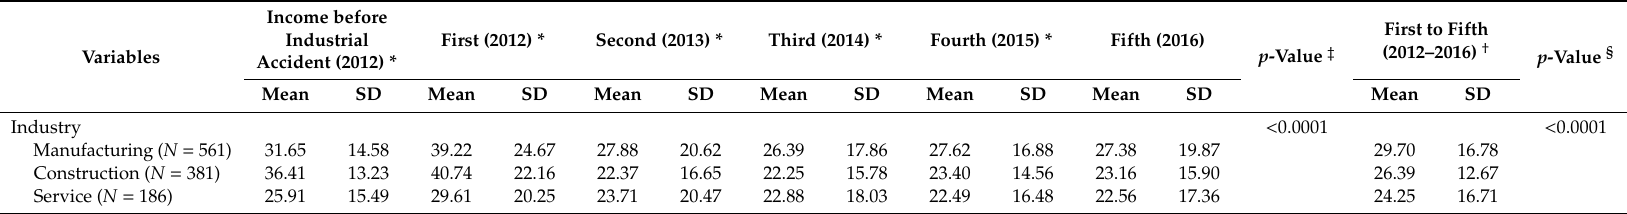
Table 2. Relationship between industry and annual income changes before and after industrial accident (unit: million